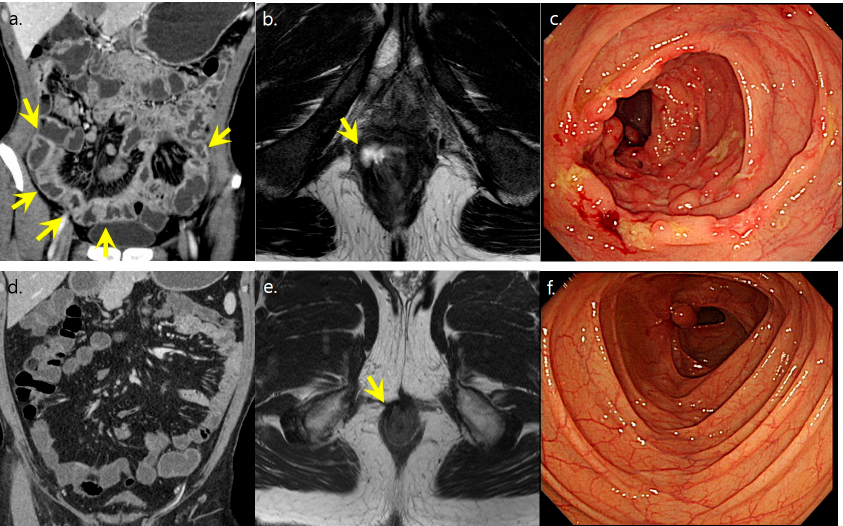
Figure 4. A 36-year-old male with Crohn’s disease showing well-controlled disease course. ( a , b ) Initial CT and MR showed active inflammation in the entire ileum and colon with perianal abscess. (arrows) CT scores was graded as severe activity. ( c ) Initial SES-CD score was graded as severe with multiple ulcers, exudates, erythema, and cobble stone appearance in the colons. ( d , e ) Two-year follow-up CT showed resolved active inflammation in both bowel loops and perianal region (arrow in ( e )), and CT scores was graded as no activity. ( f ) Patient was in clinical and endoscopic remission at the last follow up.